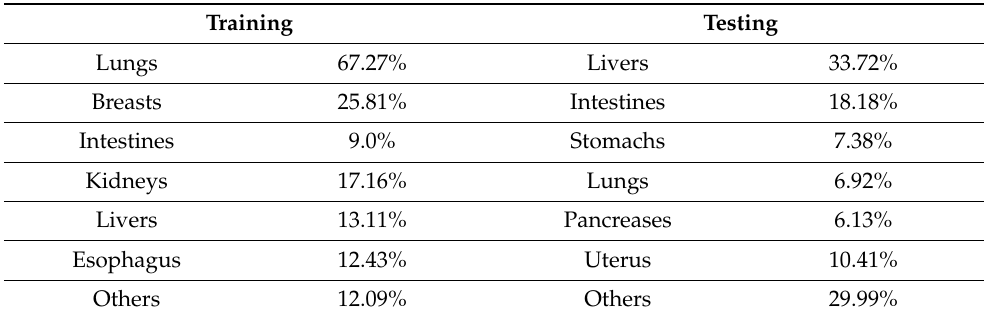
Table 2. Distribution of the i2b2/UTHealth 2010 Train and Test Sets. Tumor-Related Medical Events. The table exhibits tumor type data for the training (train) and testing (test) sets of the i2b2/UTHealth 2010 medical event extraction